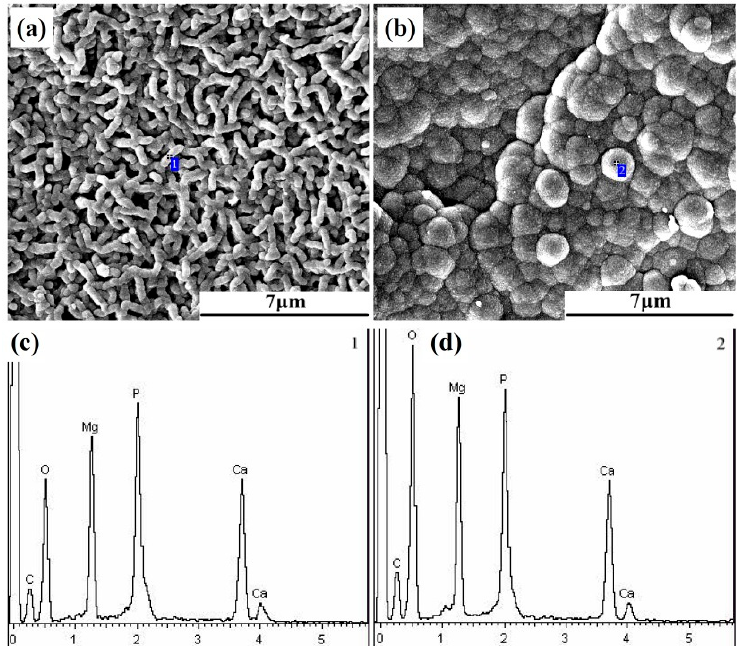
Figure 10. SEM images of corrosion products of the extruded Mg-6Zn-0.5Nd-0.5Ca alloy after aging treatment. Both ( a , b ) are the microscopic morphology of corrosion products. ( c , d ) are the EDS results of the corrosion products ( a , b ), respectively. ( c , d ) are EDS spectra at Point 1 and 2 in ( a , b ), respectively Table 4. EDS results of the corrosion products on the surface of Mg-6Zn-0.5Nd-0.5Ca alloy, at%. Point C O